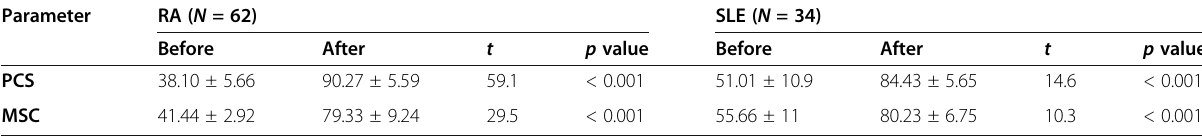
Table 3 Comparison between PCS and MSC components scores among female RA and SLE cohorts before and after remission Parameter RA ( N = 62) SLE ( N = 34) Before After t p value Before After t p value PCS 38.10 ± 5.66 90.27 ± 5.59 59.1 < 0.001 51.01 ± 10.9 84.43 ± 5.65 14.6 < 0.001 MSC 41.44 ± 2.92 79.33 ± 9.24 29.5 < 0.001 55.66 ± 11 80.23 ± 6.75 <